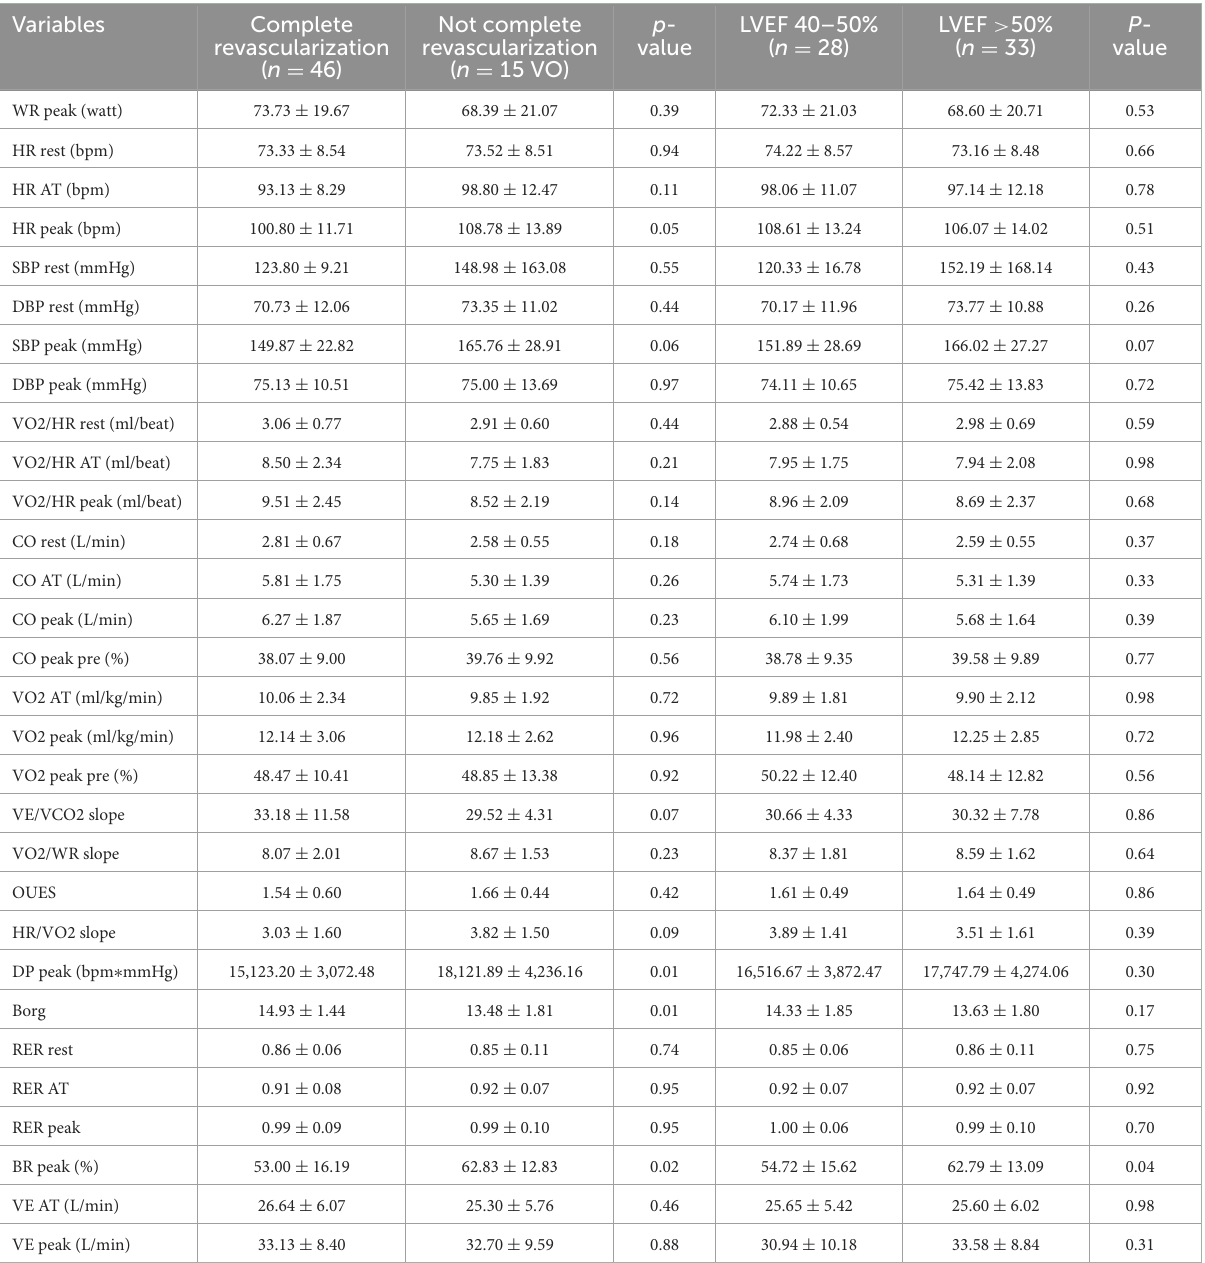
TABLE 3 CPET variables in different